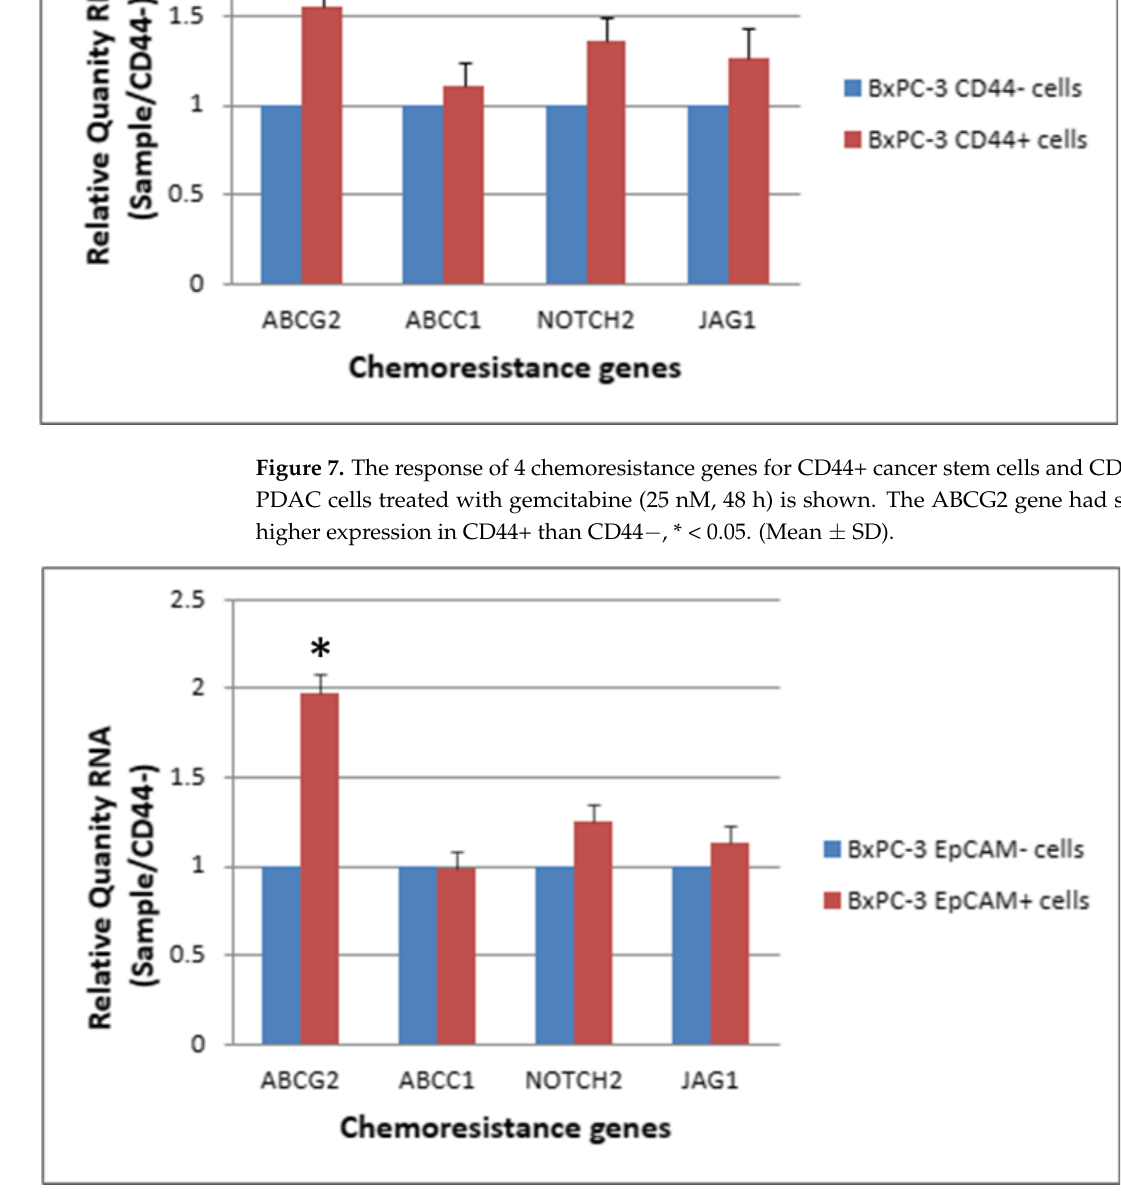
Figure 8. The response of 4 chemoresistance genes for EpCAM+ cancer stem cells and EpCAM− BxPC-3 PDAC cells treated with gemcitabine 25 nM, 48 h is shown. The ABCG2 gene had significantly higher expression in EpCAM+ than EpCAM−, * < 0.05. (Mean ± SD).